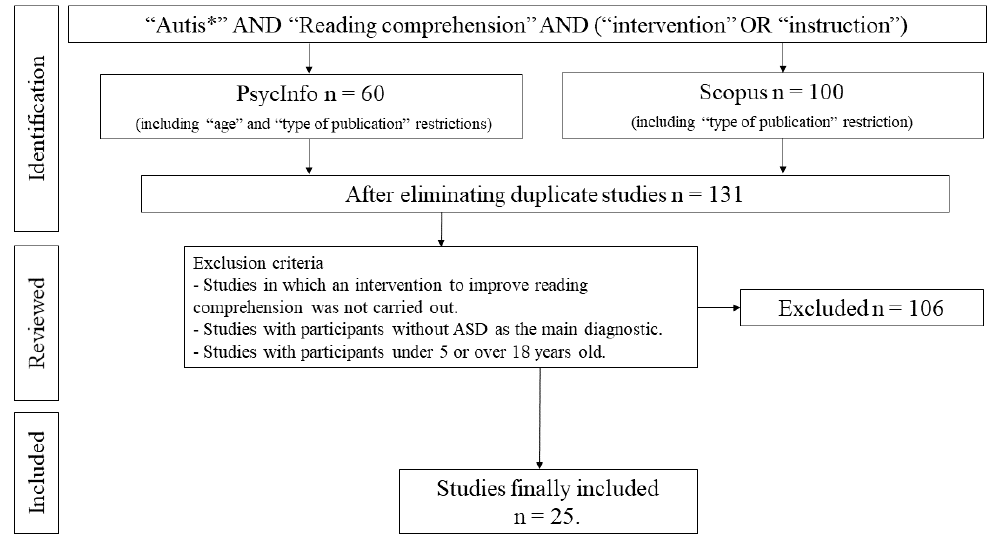
Figure 1. Flow chart of the search process.